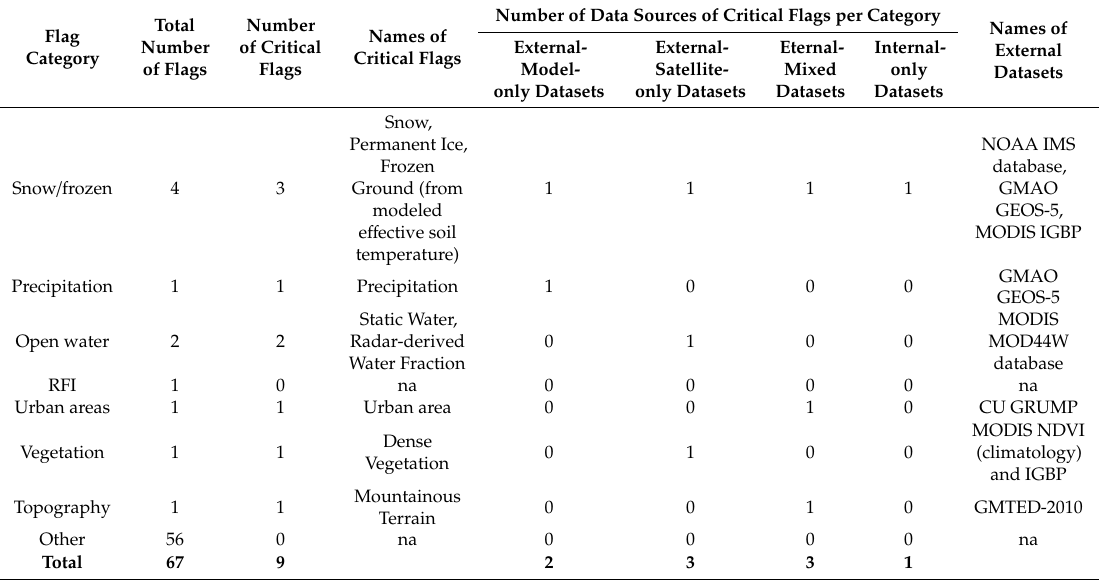
Table A2. Overview of the flagging system of the sensor dataset SMAP SM L3.